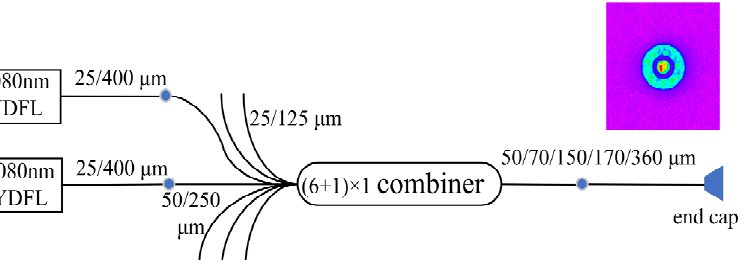
Figure 7. The diagram and the output spot when two YDFLs are injected into the central and side port of the (6 + 1) × 1 combiner.